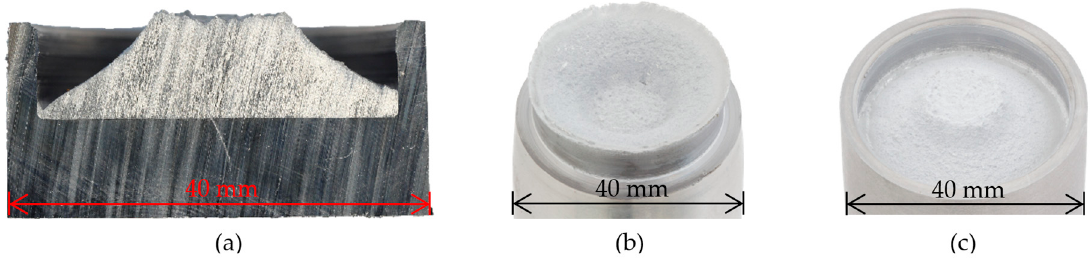
Figure 6. Specimen of Geometry A after tensile testing: ( a ) cross section; ( b ) aluminum side; ( c ) steel side.